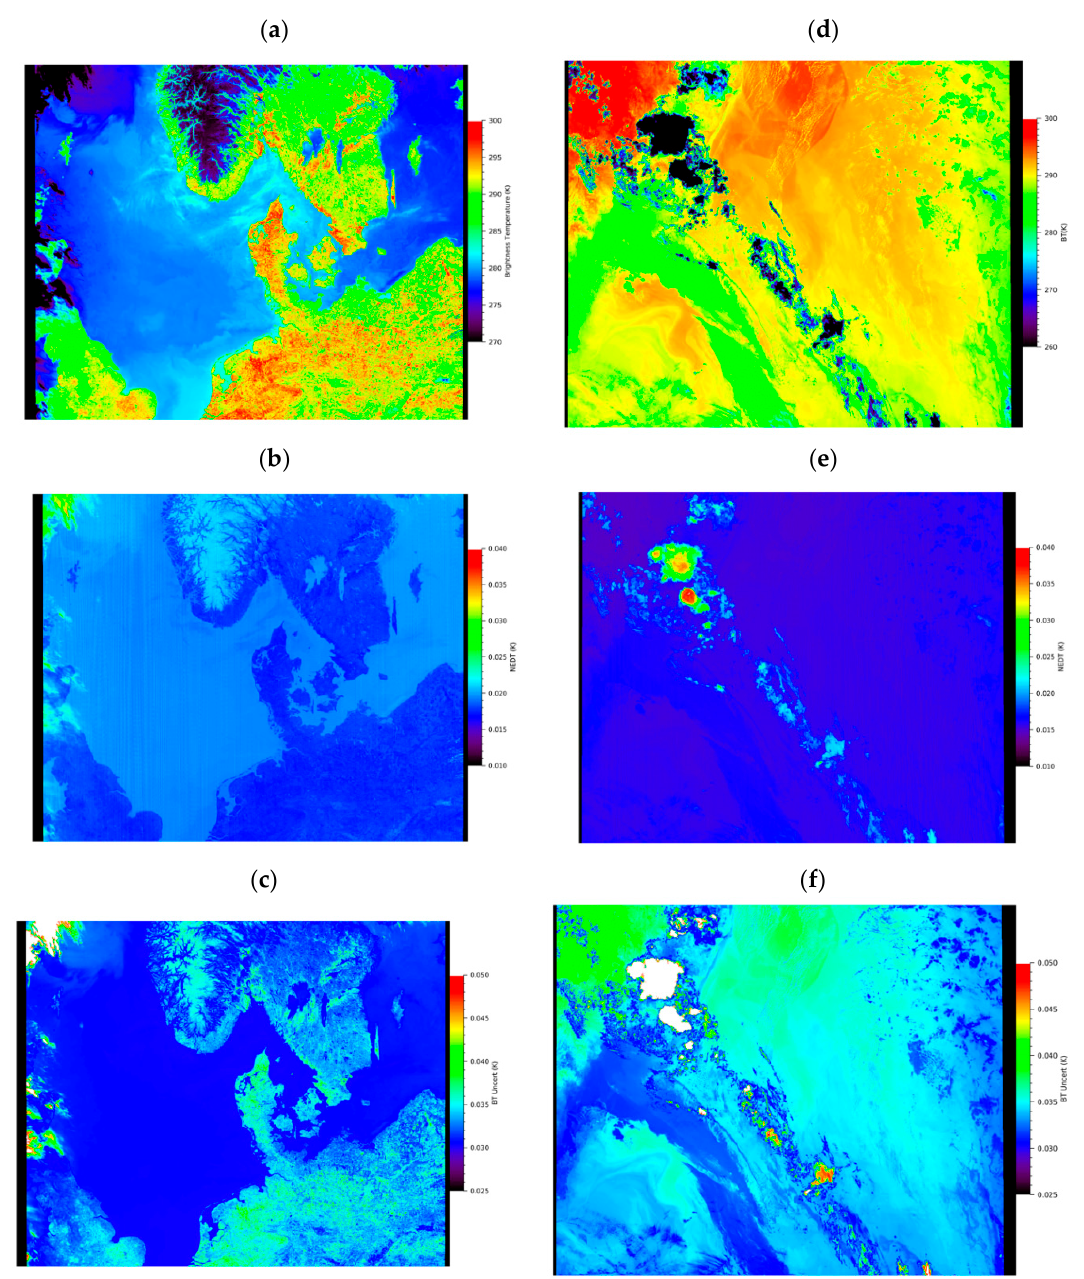
Figure 12. Sample images showing the output of the MapnoiS3 tool for SLSTR-B 12 µm BT images for a virtually cloud free North Sea on 22 April 2020 ( a – c ), and off the east coast of Australia during the extreme wildfire event on 1 January 2020 ( d – f ). The top row ( a , d ) shows the measured brightness temperatures, the centre images ( b , e ) show the fully random noise estimates and the bottom row ( c , f ) show the uncertainty due to correlated (systematic) effects.